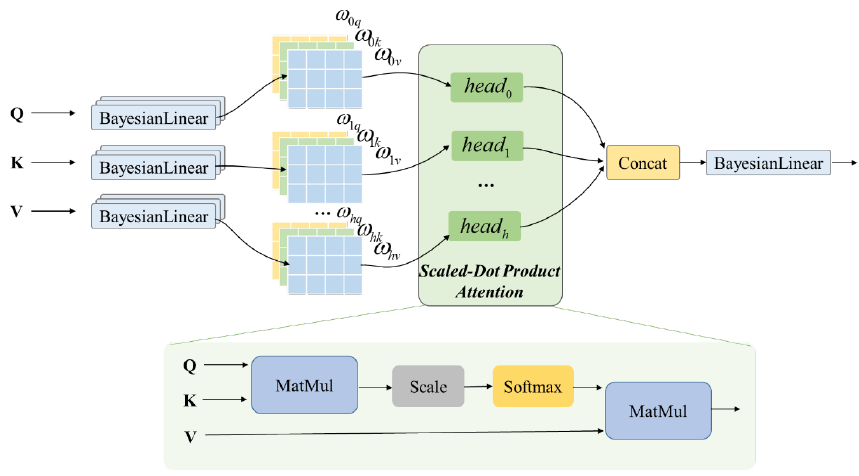
Figure 3. Bayesian multi-head-attention structure.